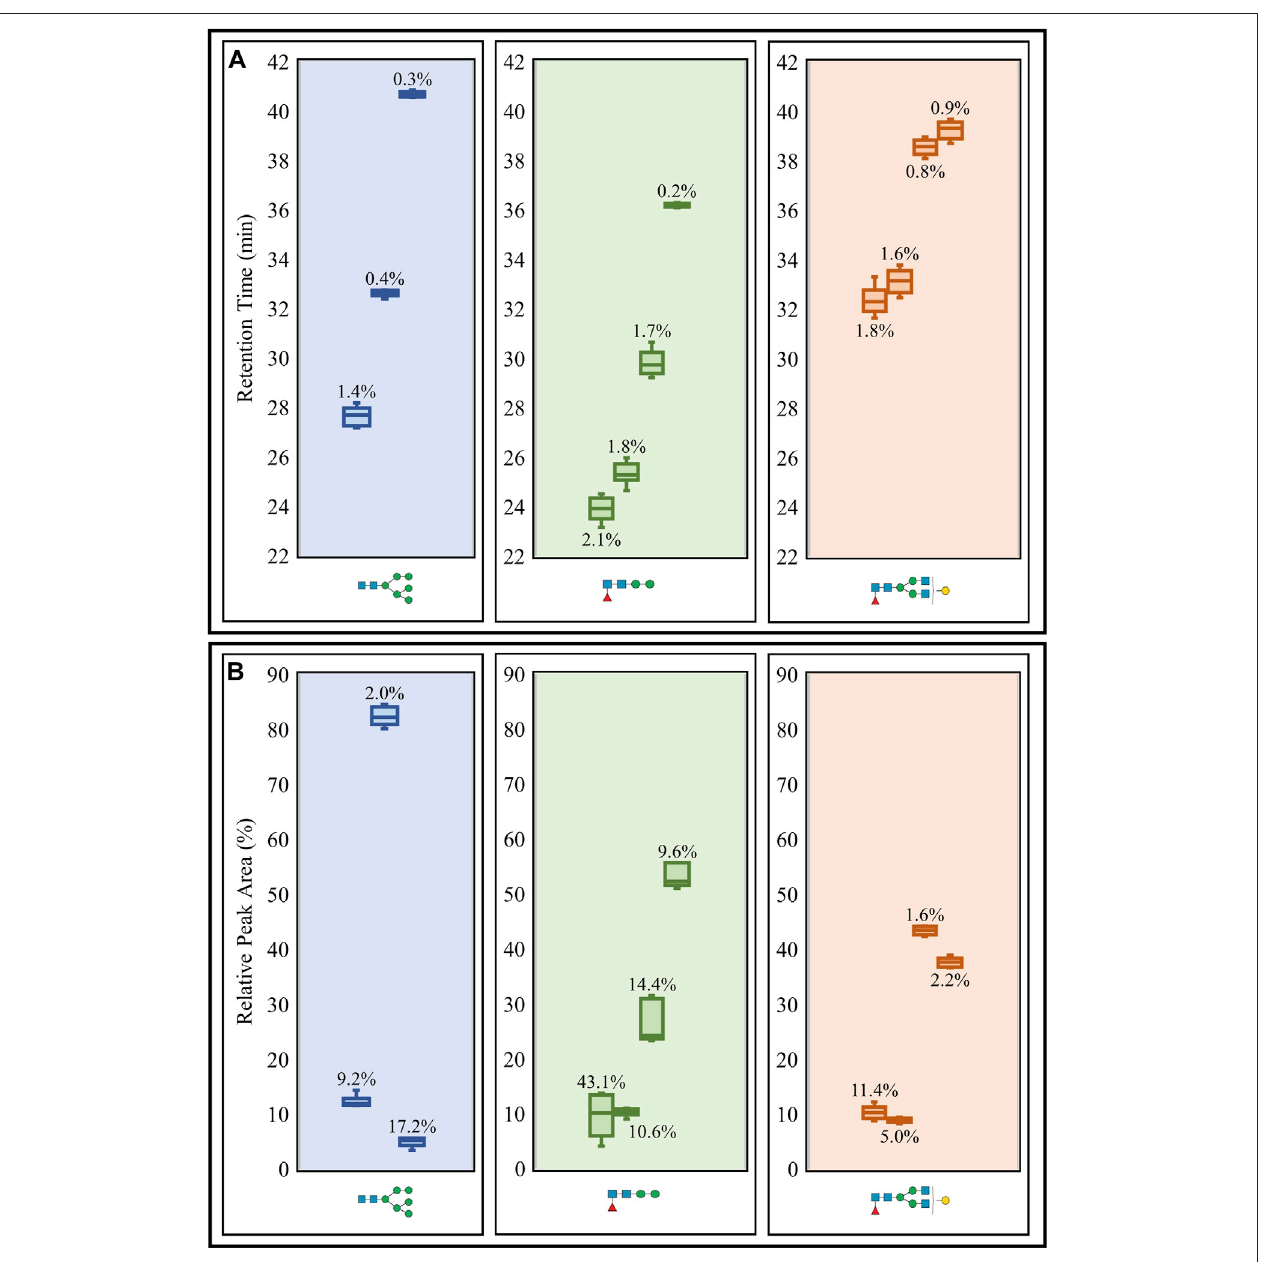
FIGURE2| Repeatabilitystudyofretentiontimes (A) andrelativepeakareas (B) ofthreerepresentative N- glycans(includingisomericstructures)released fromthe glycoprotein standard mixture. Box plots and CVs (annotated) were calculated for each N- glycan representative detected from consecutive sextuplicate PGC LC-MS runs. Raw retention time data ( Supplementary Table S2 ) and raw relative peak area data ( Supplementary Table S3 ) are available.